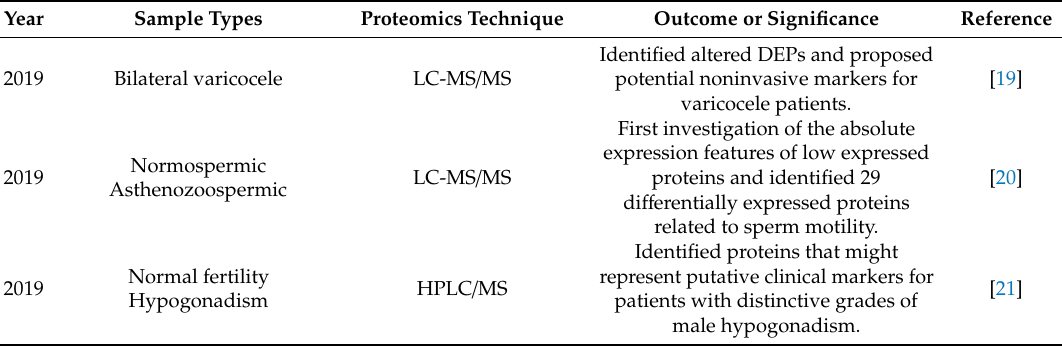
Table 1. Distinct proteomes of human seminal plasma in respective conditions reported from 2012 to